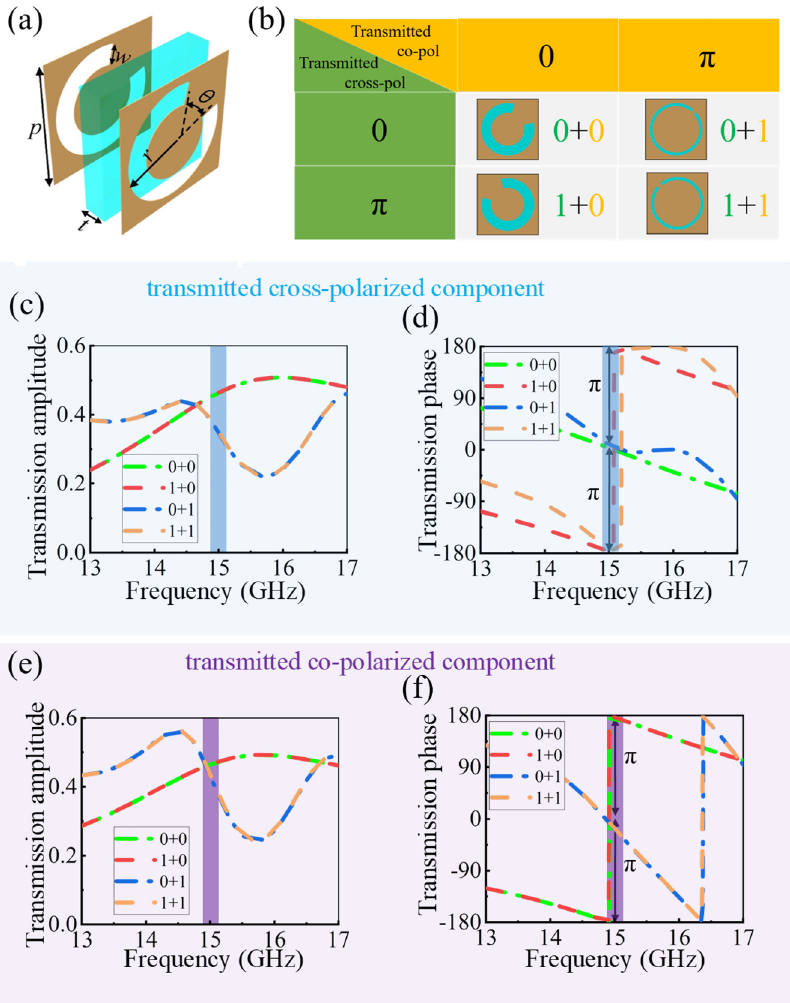
procedure between the holography imaging and meta- hologram is proposed to obtain the uniform intensity pro-